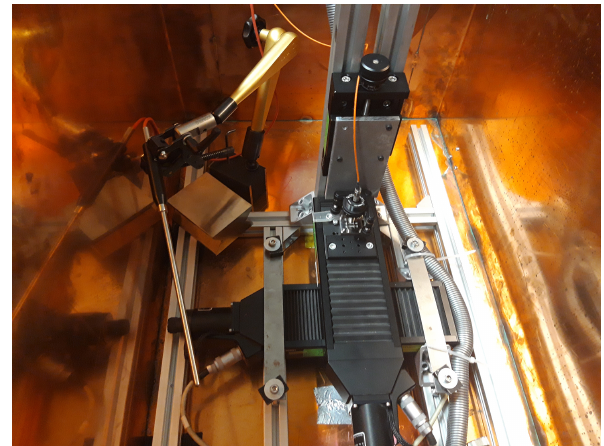
Figure 6. Measurement setup in the temperature box with an XY stage as a positioning unit.